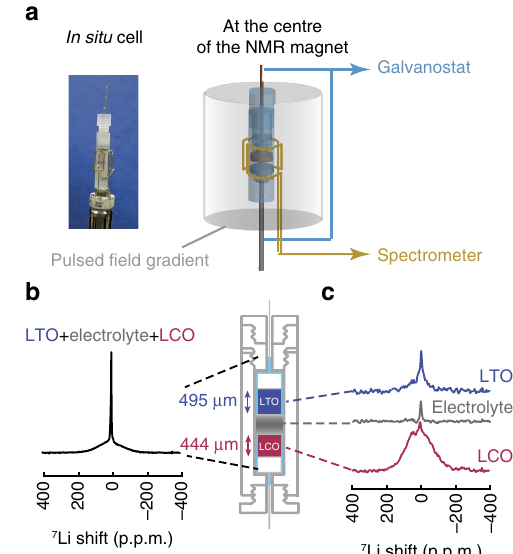
Figure 1 | Experimental set-up and localized NMR spectra. ( a ) The in situ electrochemical cell is located in the centre of the radio-frequency and PFG coils used for spectroscopy and imaging; it is connected to a galvanostat for (dis)charging. ( b ) 1D 7 Li NMR spectrum showing the overlap of the signals of the two electrodes (LCO, LTO) and of the liquid electrolyte. The electrolyte is soaking the whole cell. ( c ) Localized spectra obtained with ISIS for LTO, the electrolyte in the separator and LCO. The localized spectra of the electrodes contain a sharp component at 0p.p.m. due to Li þ ions in the liquid electrolyte soaking the electrodes. The electrolyte peak is more intense in b because of contributions from the liquid at the top and bottom of the electrodes (not shown in c